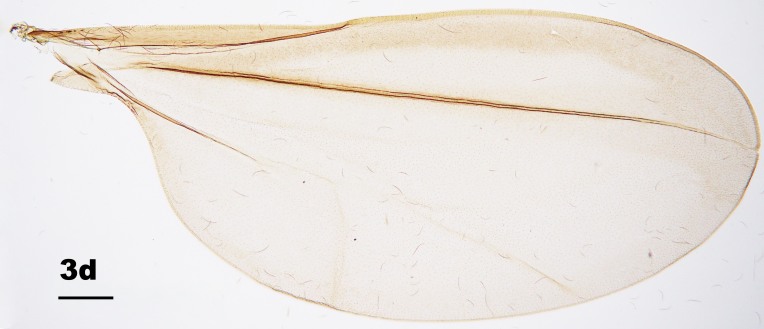
P.
neolitseae Yukawa